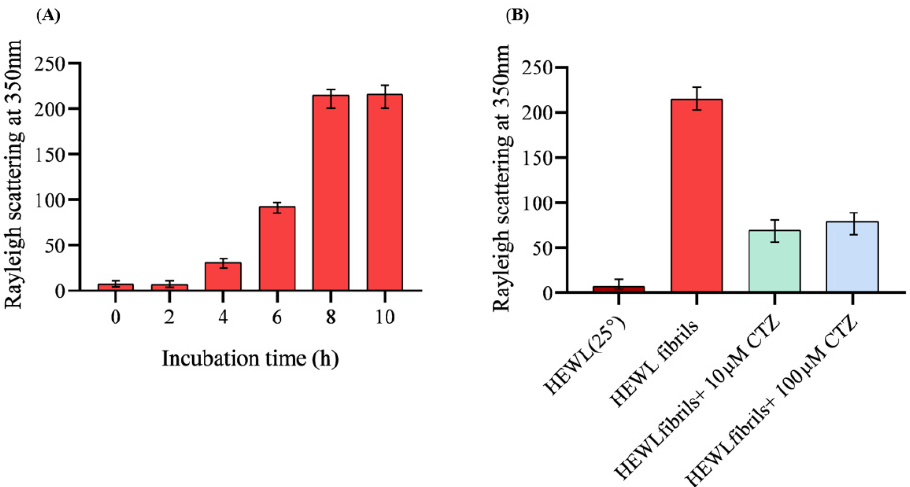
Figure 2. Rayleigh scattering measurements of 10µM HEWL. ( A ) Represents HEWL fibril for- mation incubated at pH2.0, 55ºC for 10 hrs. ( B ) Shows the effect of 10µM and 100µM CTZ on HEWL aggregation after 8hrs incubation at pH2.0, 55 ºC .